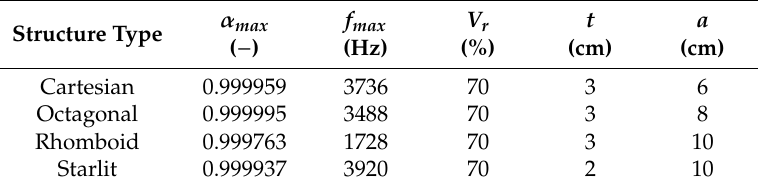
Table 2. Maximum values of the sound absorption coefficient and their corresponding excitation frequency, volume ratio, sample thickness and air space size for the investigated ABS samples with different structure types.